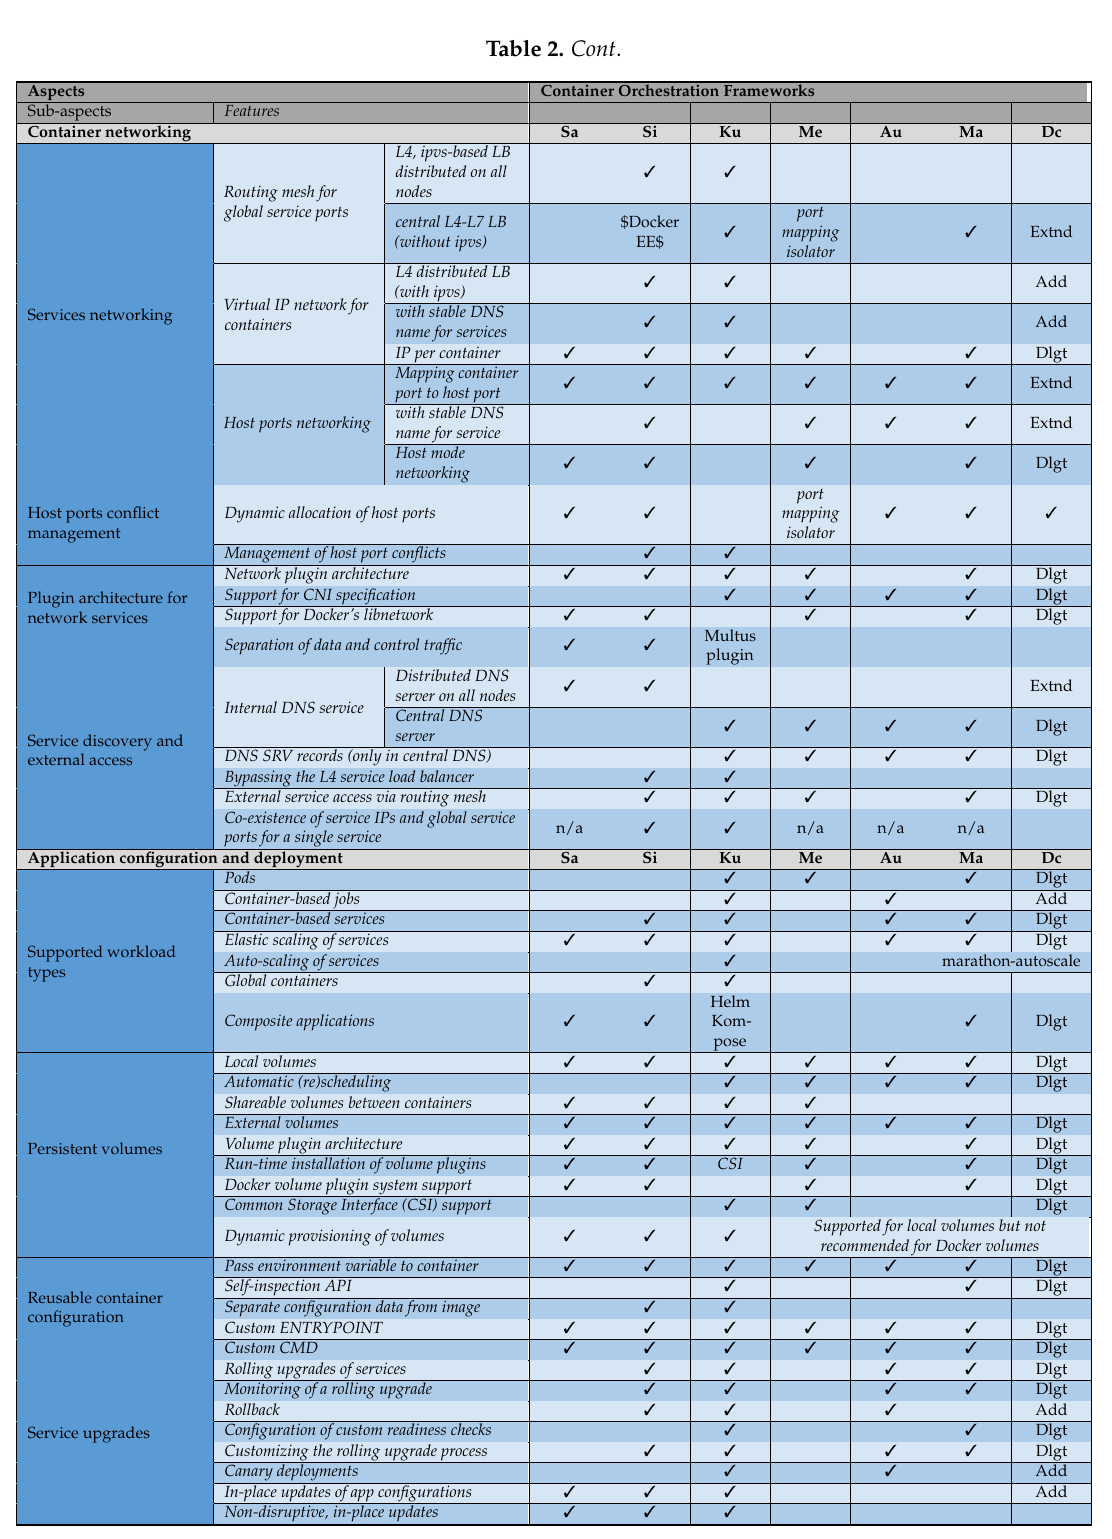
Table 2. Cont . Container Orchestration Frameworks